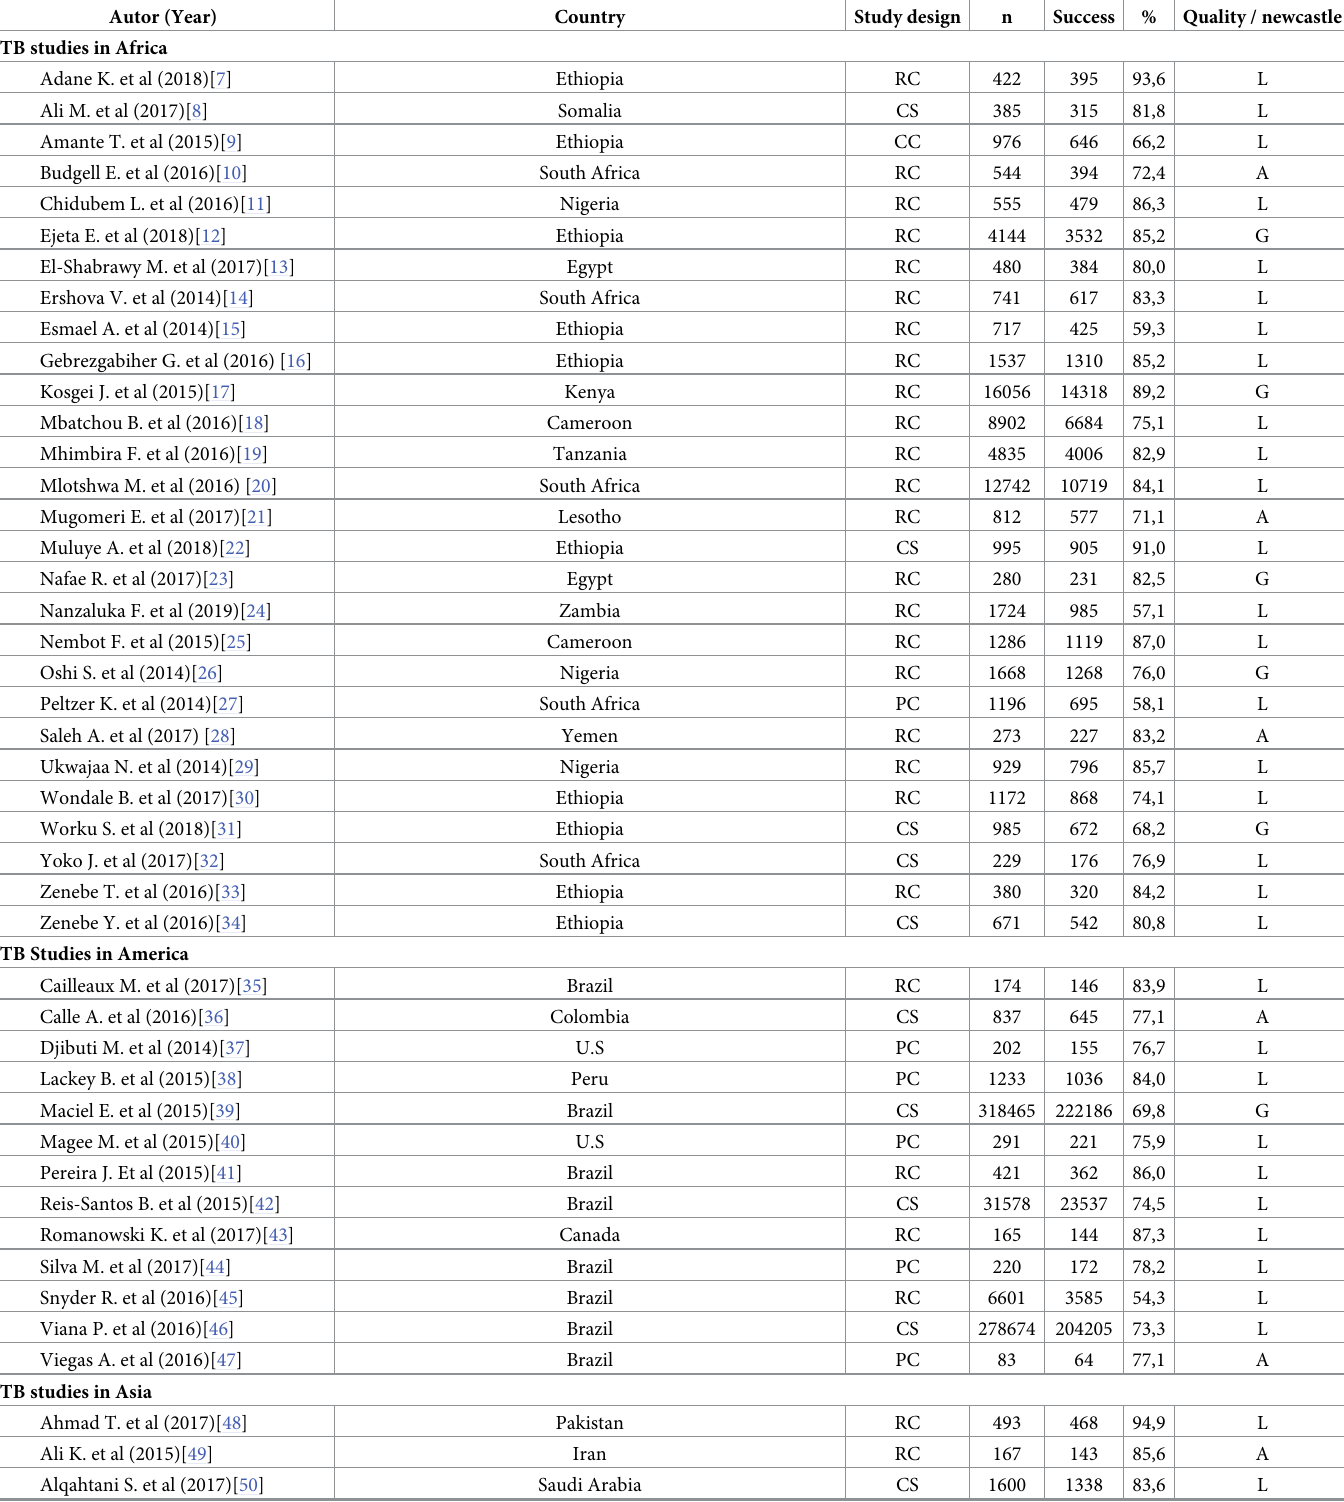
Table 2. Characteristics of the included studies according to continent of origin and population